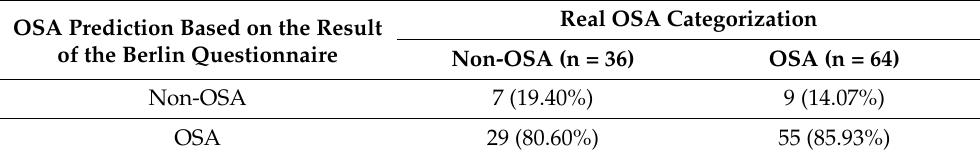
Table 6. Two-category OSA prediction based on the results of the Berlin questionnaire (the table shows the number of cases per 100 patients and the percentage distribution of scores within the non-OSA and OSA categories). OSA: obstructive sleep